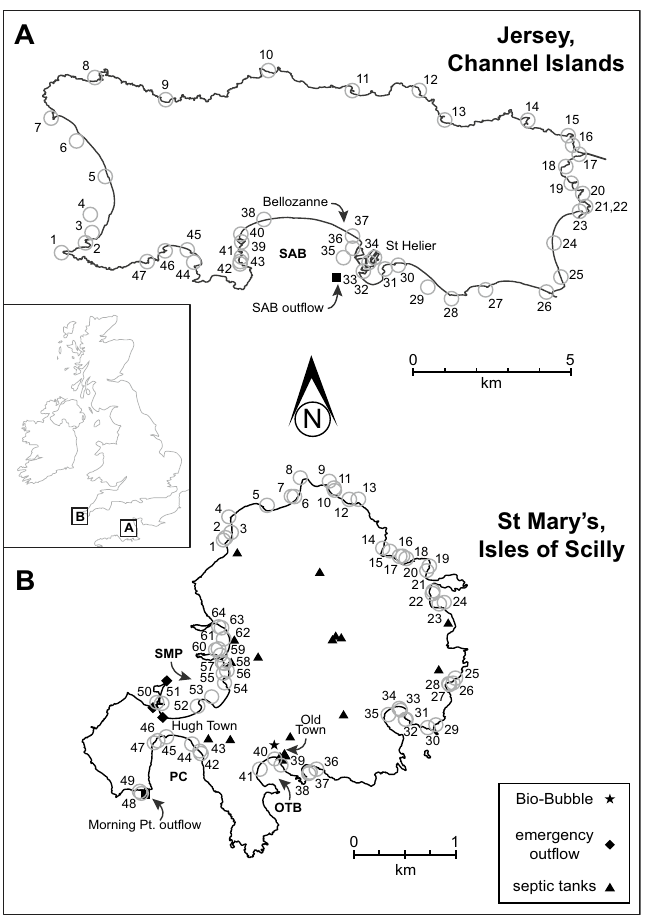
Figure 1. Map of the islands investigated in this study: ( A ) Jersey, Channel Islands; ( B ) St Mary’s, Isles of Scilly. Sample locations are indicated by numbered grey circles. Key locations discussed in text are also indicated.